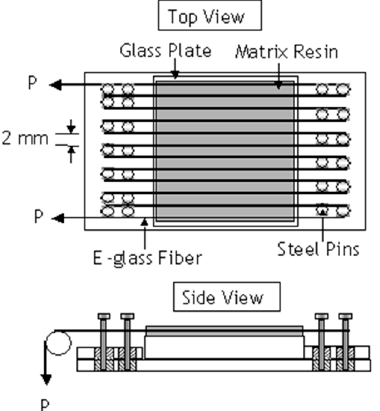
Figure 1. Schematic illustration of the pre-stressing method developed by Jorge et al. [34] where the reinforcing fibres were wound around a series of pins; the pre-load was applied using weights. “P” represents the load on the fibre bundle.